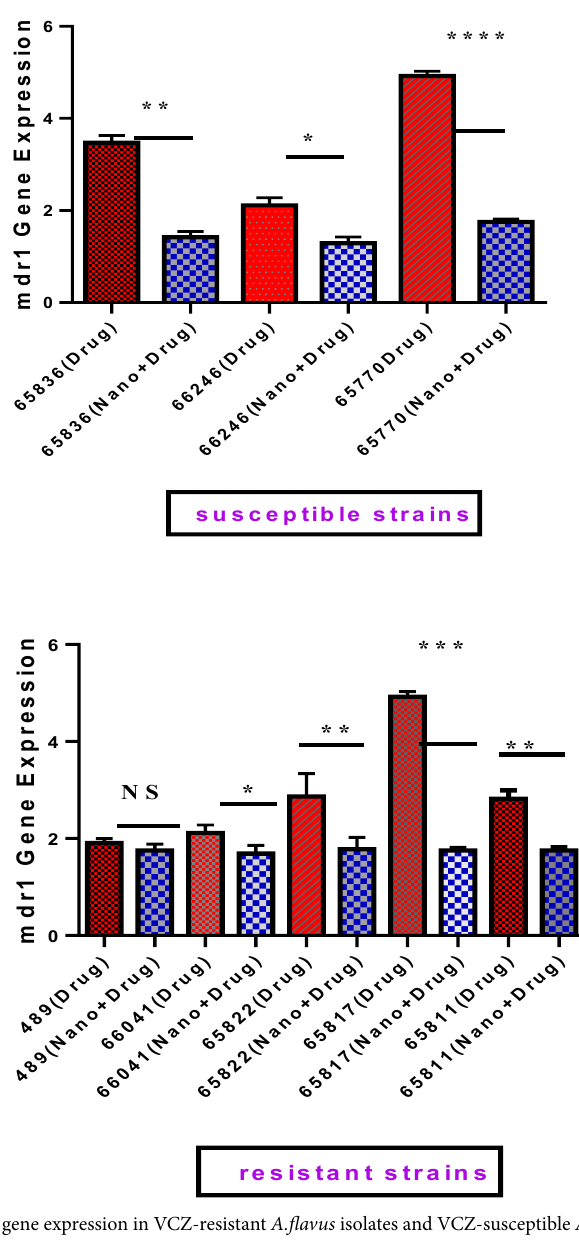
Fig. 4. MDR1 gene expression in VCZ-resistant A.flavus isolates and VCZ-susceptible A.flavus